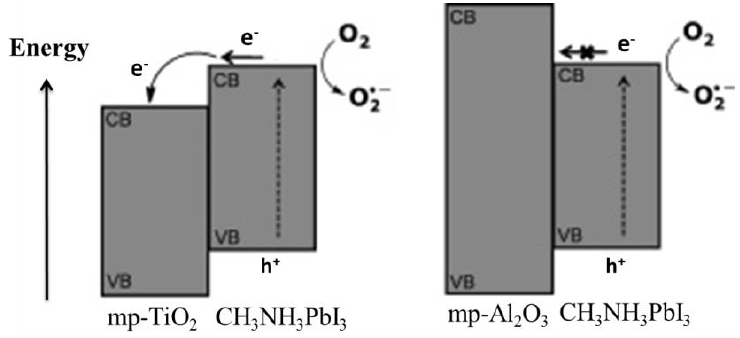
Figure 4. Schematic model showing the electron transfer of the photo-excited electrons in the MAPbI 3 layer to oxygen resulting in the formation of superoxide. Reprinted with permission from the reference